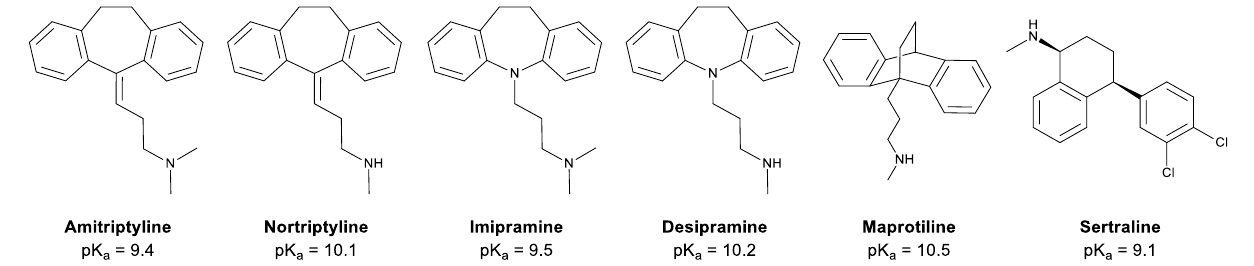
Figure 1. Chemical structures of the model TCAs.